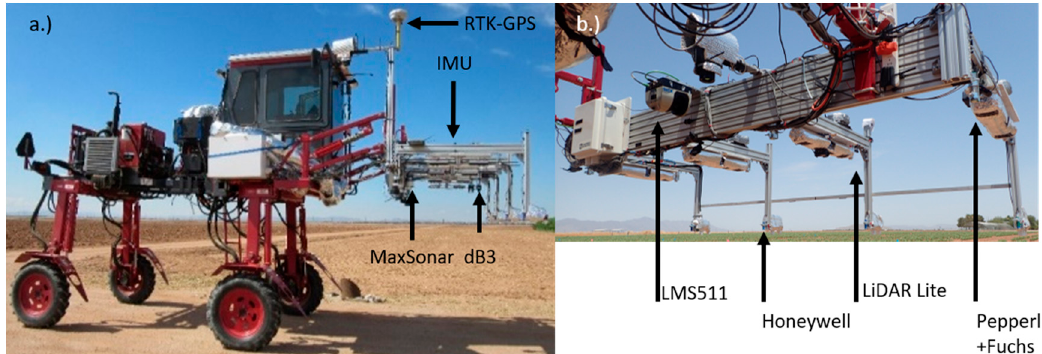
Figure 1. The high-clearance Lee Agra Avenger tractor fitted with a modified front boom using aluminum T-slot to mount the proximal sensors. The four arms on the modified boom that carry the sensors which include inertial measurement unit (IMU), real-time kinematic—global positioning system (RTK-GPS) and two ultrasonic transducer sensors (MaxSonar and dB3) in 2016 ( a ), and the sensor array used in 2017 data collections ( b ).